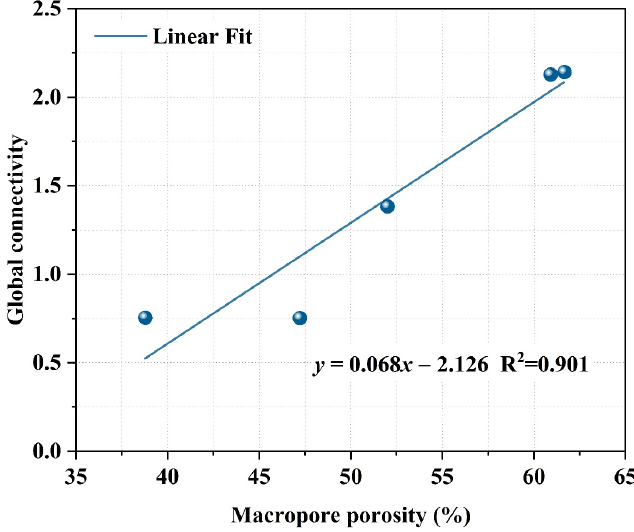
Figure 17. Regression analysis of pore connectivity of geopolymer foams.